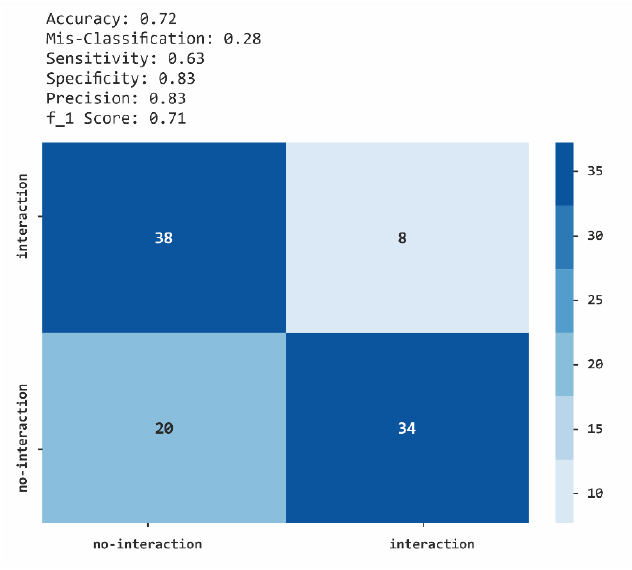
Figure 5.5. Confusion Matrix for threshold value